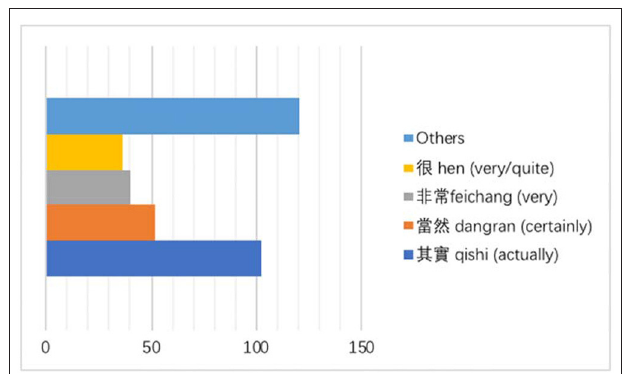
FIGURE 3 | Frequency of intensifiers added by interpreters